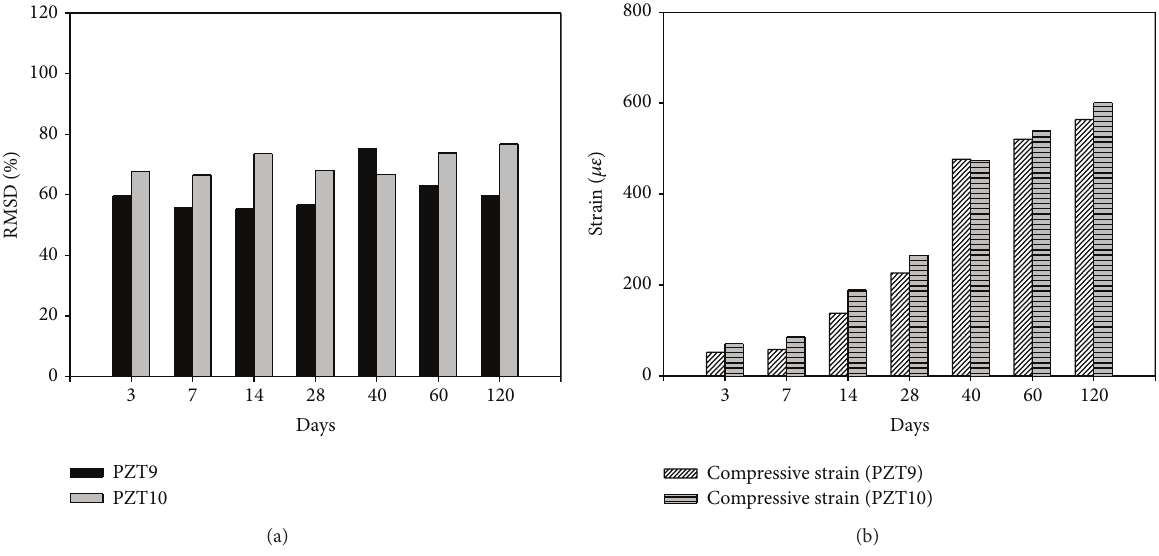
Figure 23: Comparison of PZT9 and PZT10: (a) RMSD value and (b) strain of concrete around EMI